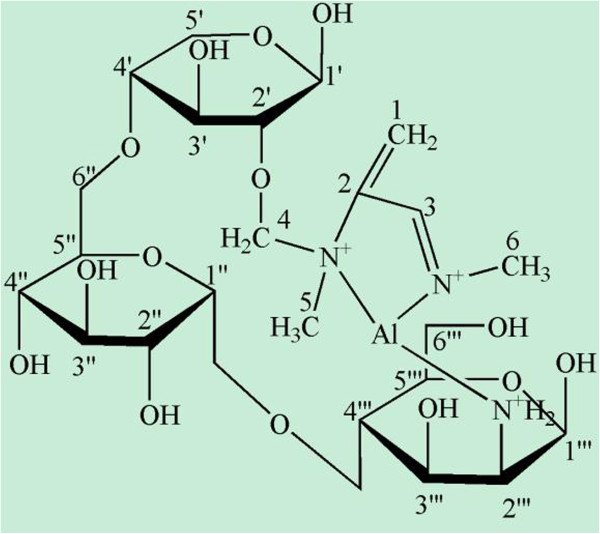
The chemical structure of Grailsine-Al-glycoside.